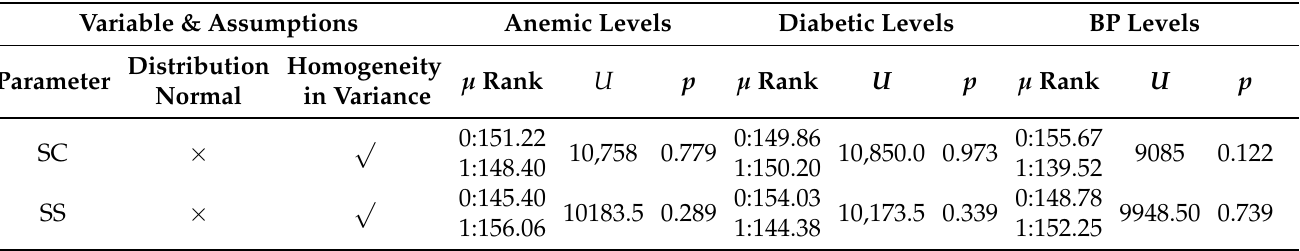
Table 8. Impact of SC and SS w.r.t Anemic, Diabetic and BP